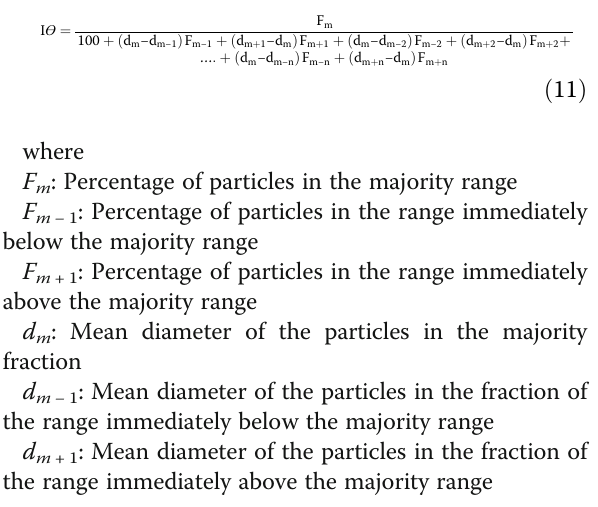
Setting of parameter limits, transformation of experimental parameter values into radius limits, and construction of SeDeM diagrams